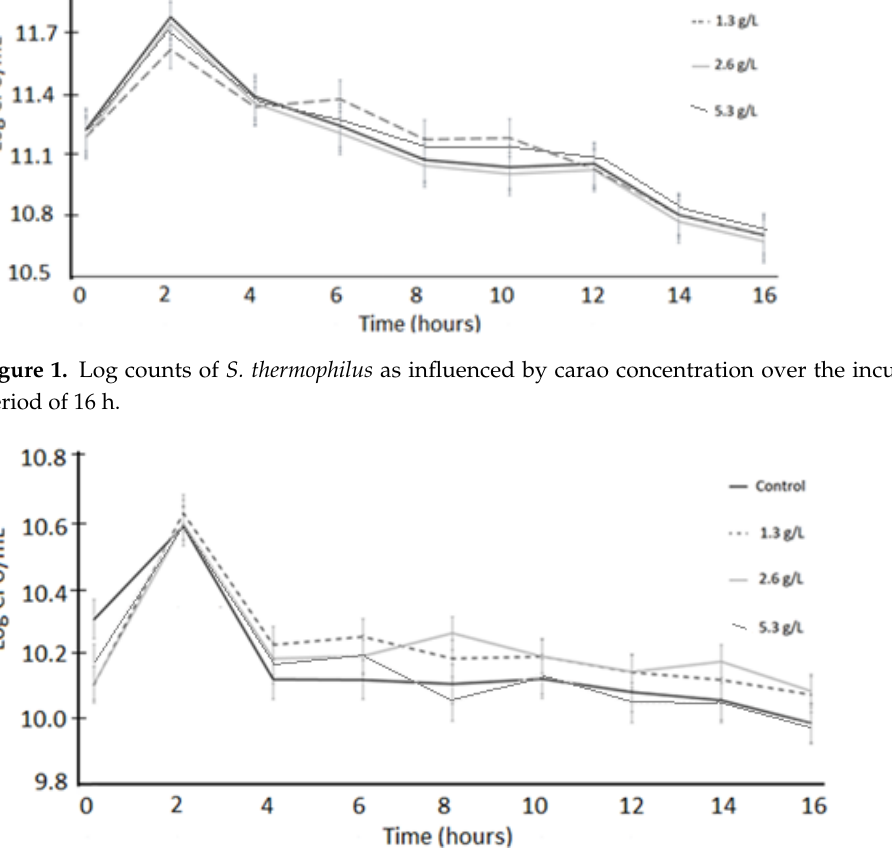
Figure 2. Log counts of L. bulgaricus as influenced by carao concentration over the incubation period of 16 h.